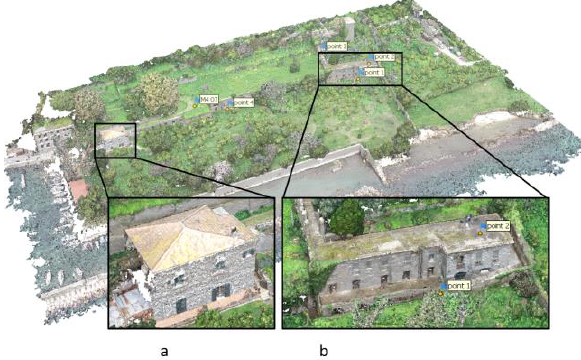
Figure 1. Overall area surveyed outside the complex and distribution of ground control points acquired. The detail boxes show the buildings a) and b) taken into consideration for the comparisons between the various survey methods, presented